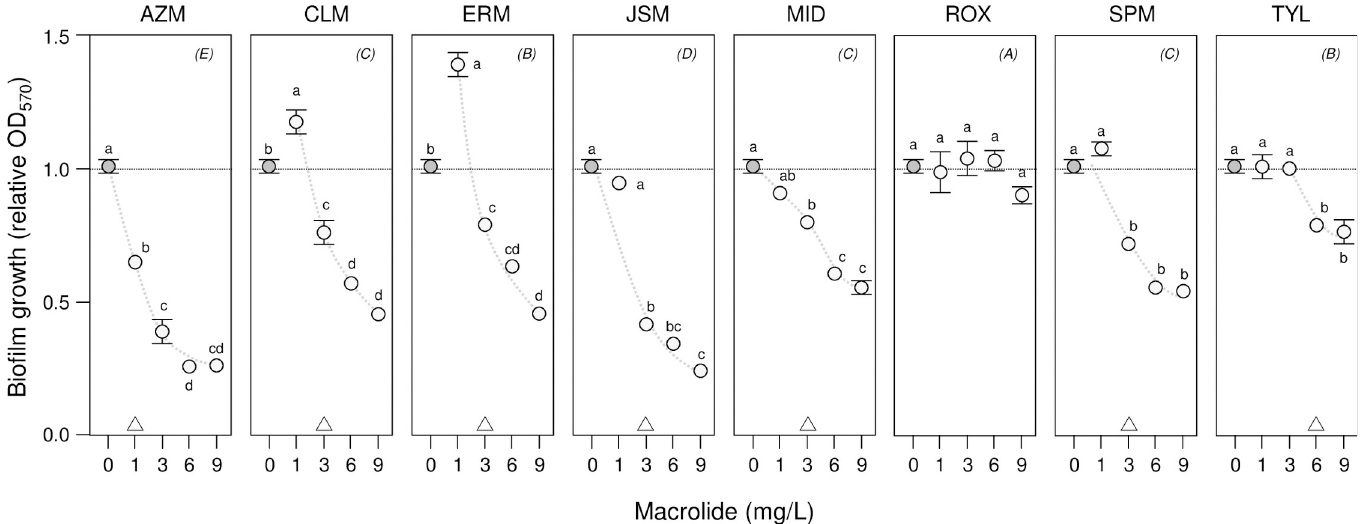
Fig 1. Optical density measurements of K . pneumonia biofilm growth show inhibition by macrolides. The inhibition of K . pneumonia ATCC 10031 biofilm growth by eight macrolides was investigated by biofilm assays with optical density (OD 570 ) measurements after 24 h incubation. Mean relative OD 570 ± SE ( n = 3) is shown, with the no-macrolide (control) treatment indicated by dark circles and 1–9 mg/L macrolide treatments by light circles (trends are suggested by dashed curves). Means not connected by the same letters within panels are significantly different (LSMeans Differences Tukey HSD, alpha = 0.05 for individual macrolide mixed-effects models; note no significant differences for ROX). Triangles at the bottom of panels indicate biofilm minimum inhibitory concentrations (MIC) where relative OD 570 was first significantly reduced by macrolide treatment. Macrolides not connected by the same letters indicated in parentheses in the top-right of each panel are significantly different (LSMeans Differences Tukey HSD, alpha = 0.05 for combined macrolide mixed-effects model of relative OD 570 ).